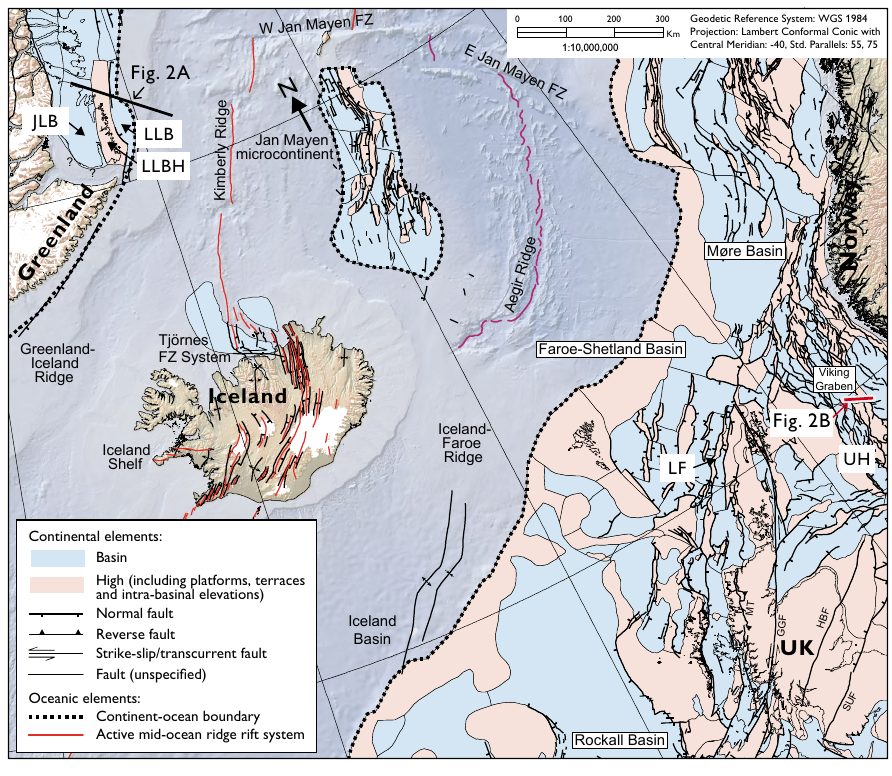
Fig. 1. Locations of North Atlantic Ocean sedimentary basins (blue) and highs (pink). Liverpool Land Basement High ( LLBH ), Liverpool Land Basin ( LLB ) and Jameson Land Basin ( JLB ) are located on the western North Atlantic conjugate margin. The Lancaster field ( LF ) and Utsira High ( UH ) basement petroleum reservoirs are located on the eastern North At- lantic conjugate margin (modified from Hopper et al.